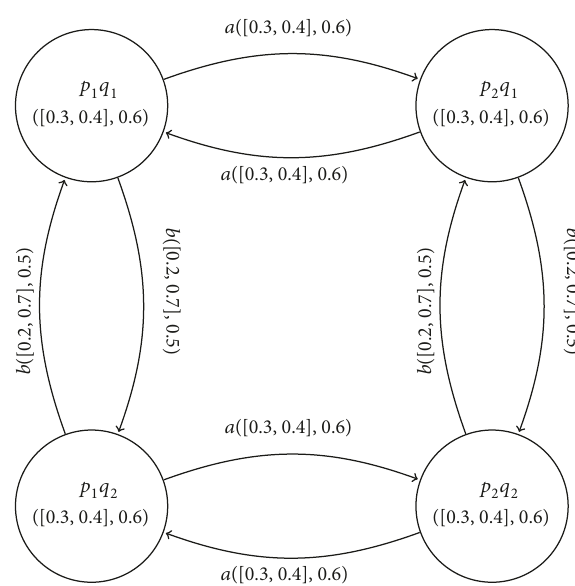
Figure 8: ̂𝜑 ∘ ̂𝜓 is a good subsystem.